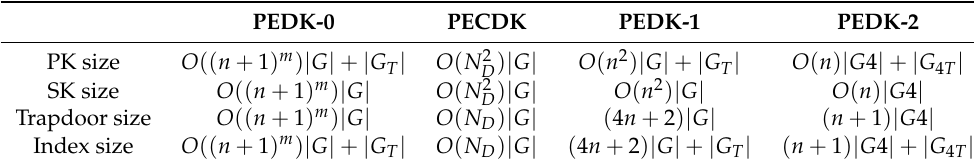
Table 3. Comparison with the previous schemes in space